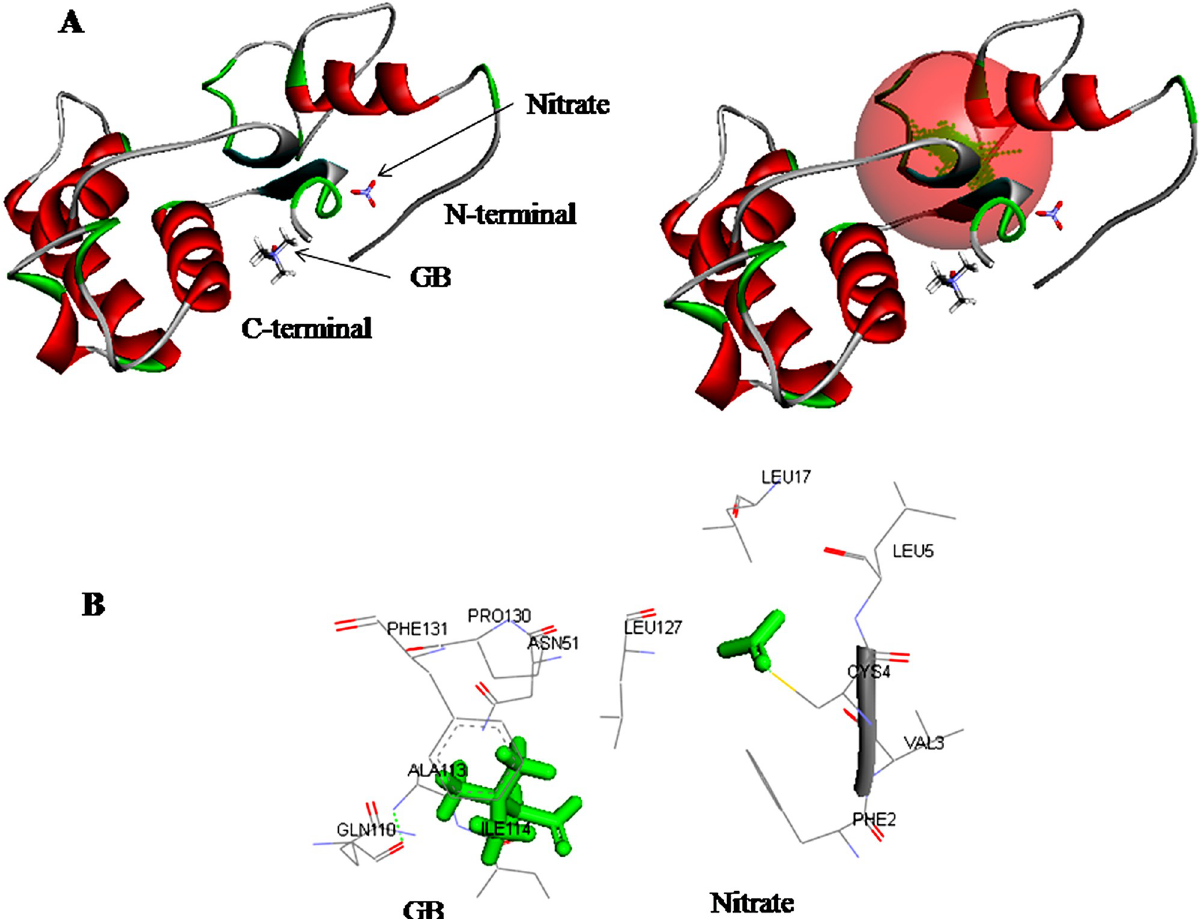
Fig 15. Docking of ligands GB and nitrate with target protein nrtD. (A) Poses of docked complexes; green color in sphere indicates prominent active site, on which the ligand interacted. (B) 3D level interaction.